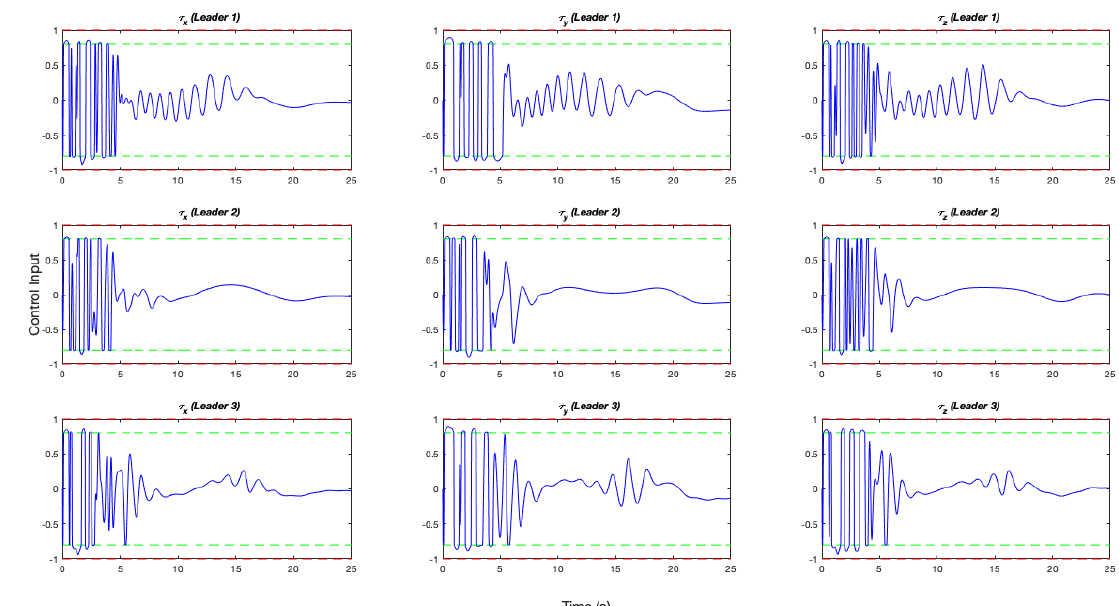
Figure 8. Control input of the leaders (blue is the actual control input) ( µ = 100).